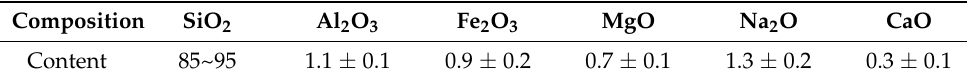
Table 3. Composition of silica fume